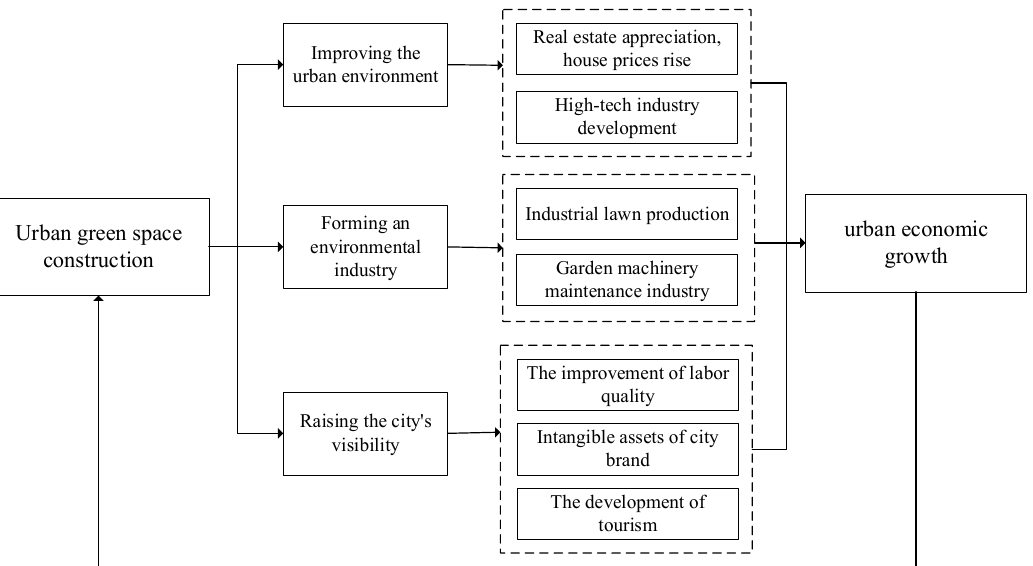
Figure 1. Analysis of the promotion function of green space to economy.